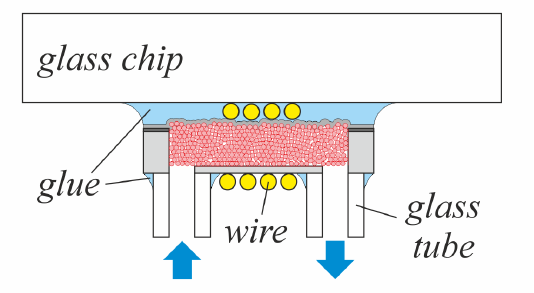
Figure 4. Flow-through setup: Cross-section (schematically) with additional glass plate and tubes for cooling